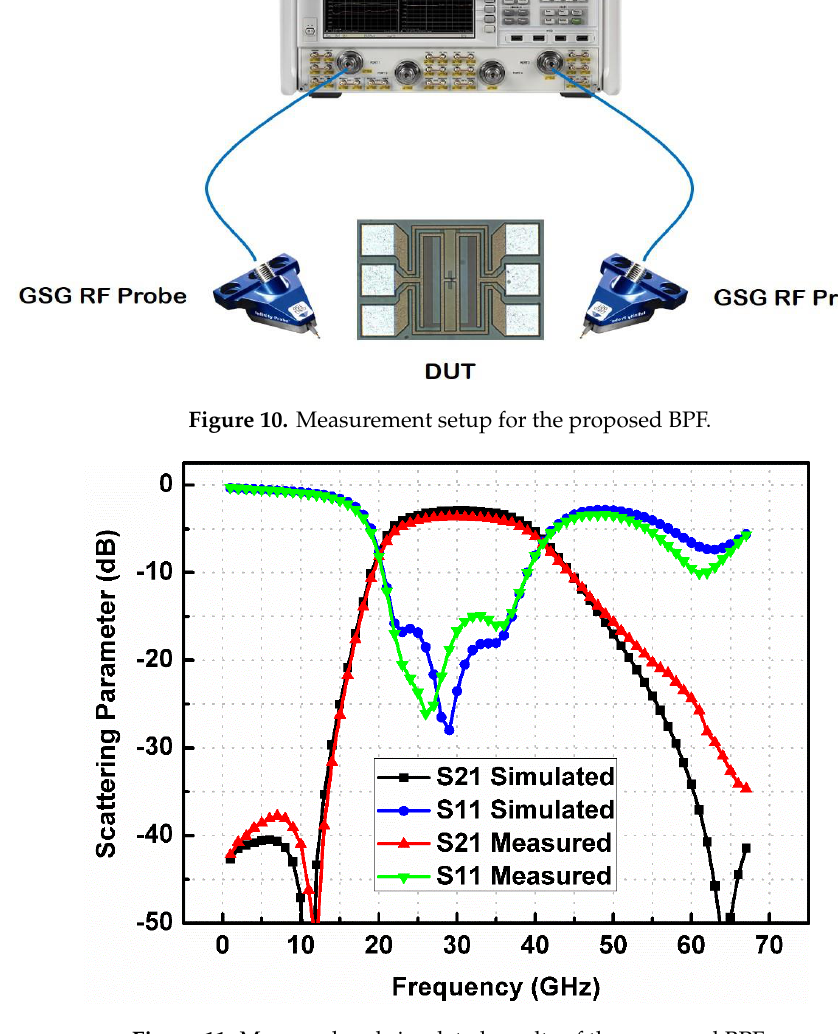
Figure 11. Measured and simulated results of the proposed BPF.